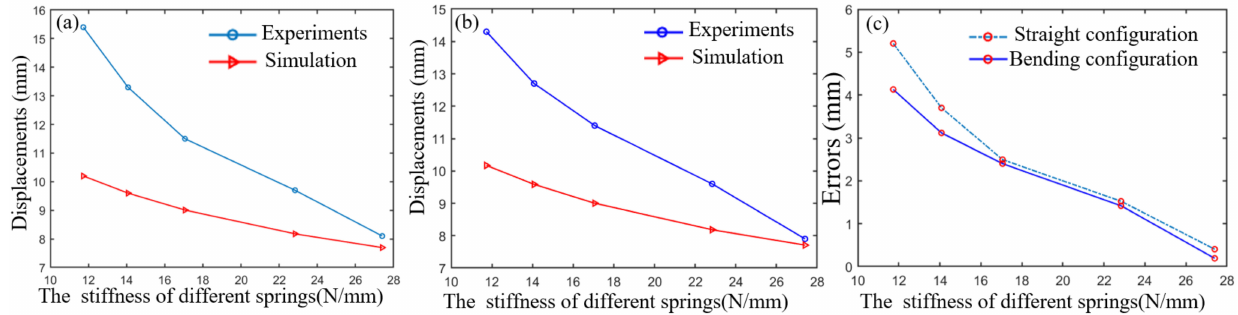
Figure 27. The displacement errors analysis of load experiences and simulation results. ( a ) The relationship between the longitude displacement and the stiffness of different springs in the straight configuration. ( b ) The relationship between the longitude displacement and the stiffness of different springs in the bending configuration. ( c ) The relationship between the longitude displacement and the stiffness of different springs in the bending